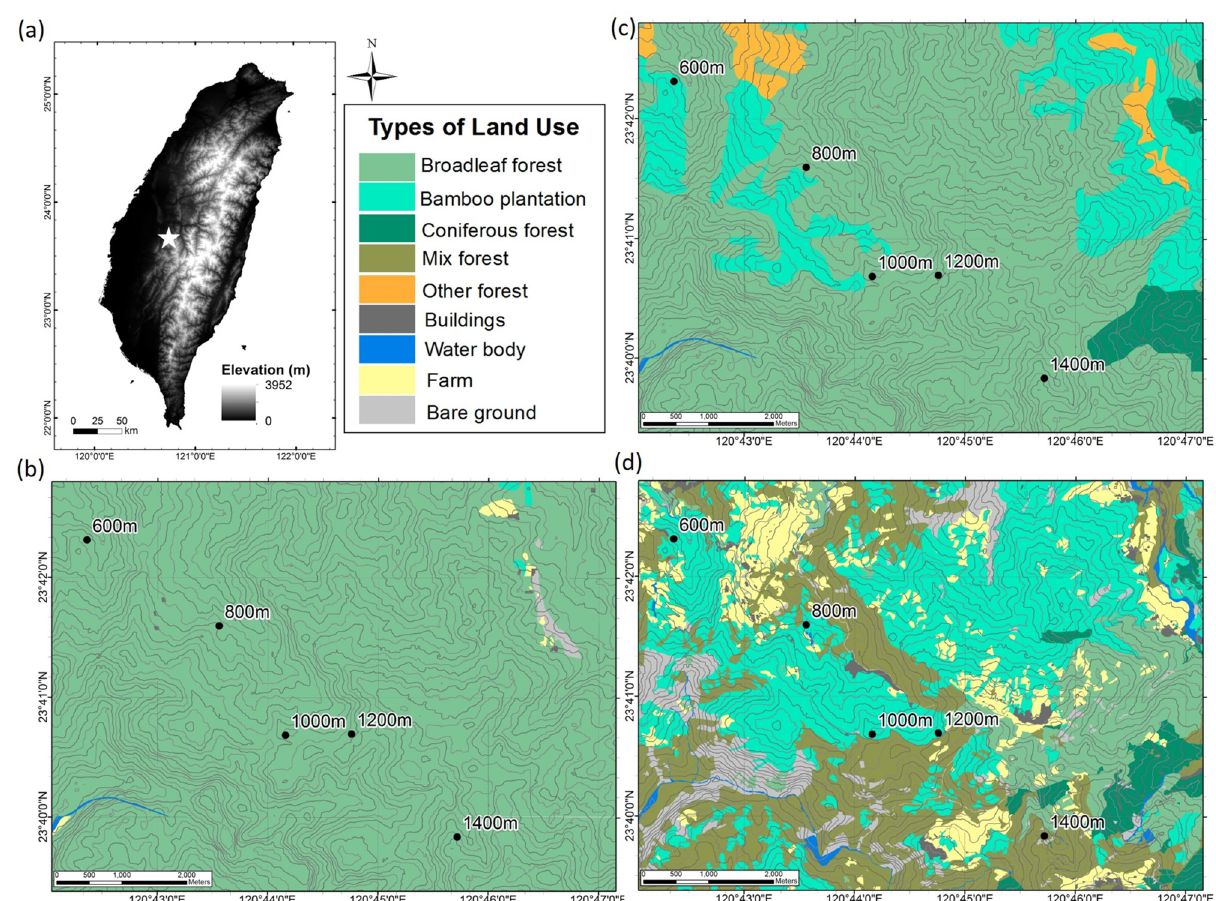
Fig 1. Maps of land use changes in five bamboo plantations. (a) The location of the study site overlaid on an elevation gradient map. (b) Land use in 1904. (c) Land use in 1956. (d) Land use in 2006. The mixed forest indicates that bamboo plantation mixed with broadleaf forest, and coniferous forest. The coordinates recorded were (120°42 ’ 22 ” E, 23°42 ’ 19 ” N) at 600 m, (120°43 ’ 32 ” E, 23°41 ’ 36 ” N) at 800 m, (120° 44 ’ 10 ” E, 23°40 ’ 41 ” N) at 1000 m, (120°44 ’ 44 ” E, 23°40 ’ 42 ” N) at1200 m and (120°45 ’ 44 ” E, 23°39 ’ 50 ” N) at 1400 m